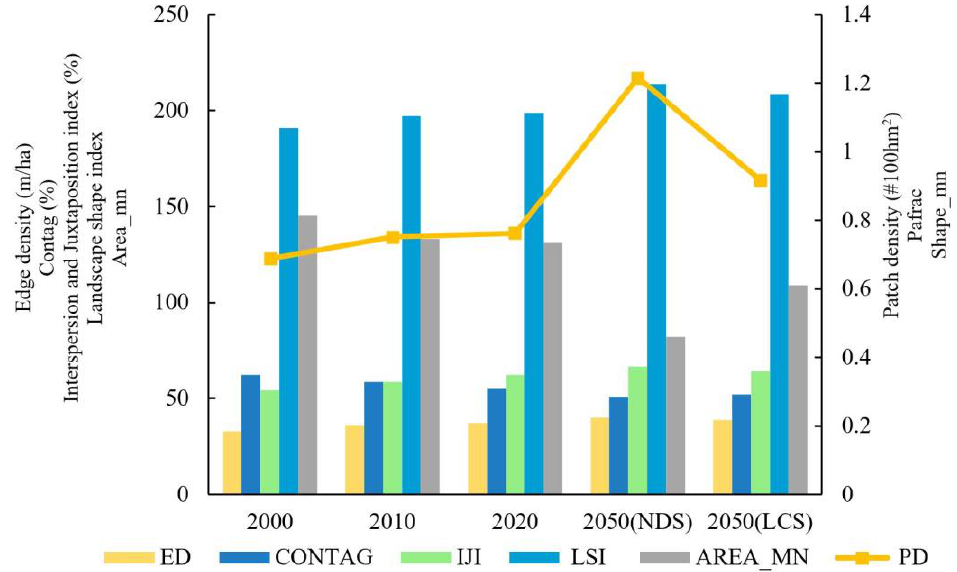
Figure 6. Landscape patterns index at the landscape level in Fujian coastal areas from 2000 to 2050.